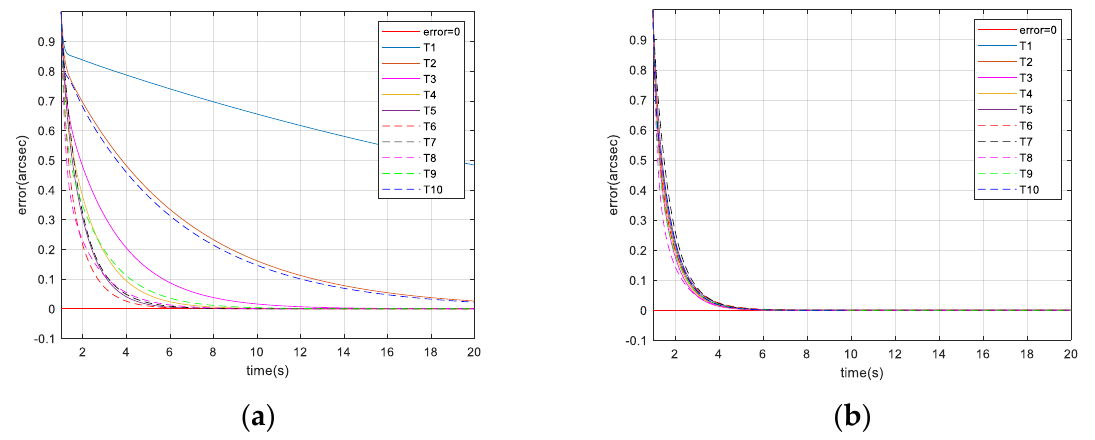
Figure 8. Tracking error of different target positions: ( a ) tracking error controlled by fixed gain and